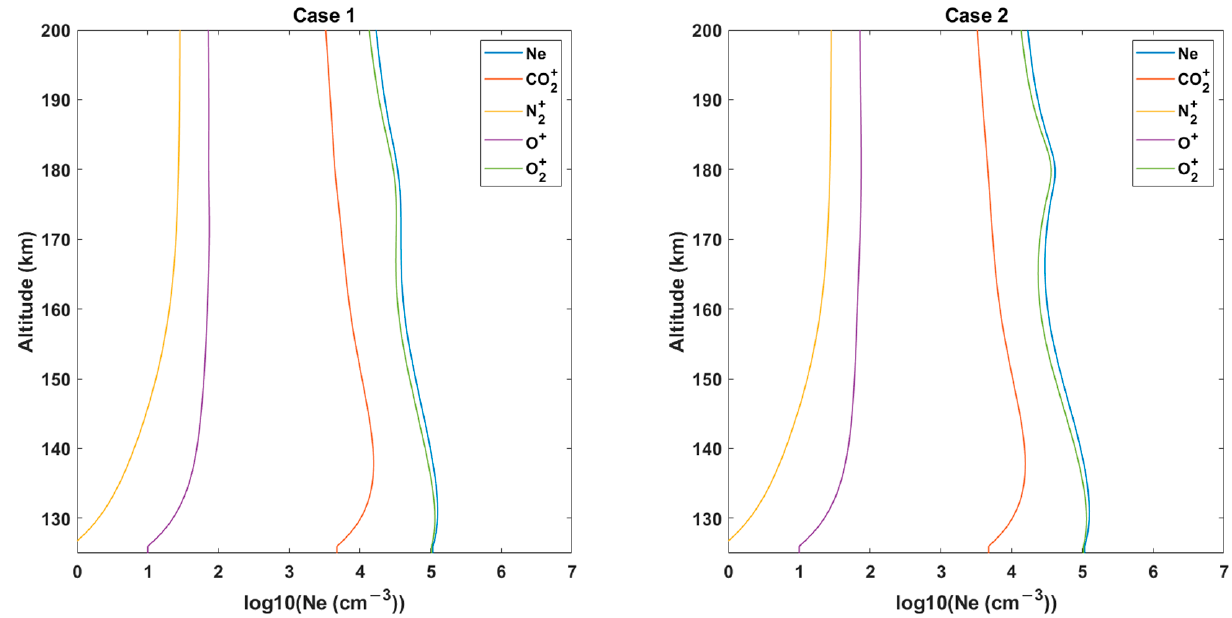
Figure 6. Densities of O 2+ , CO 2+ , O + , and N 2+ electrons in Case 1 ( left ) and Case 2 ( right ) at a running time of t = 1000 s.